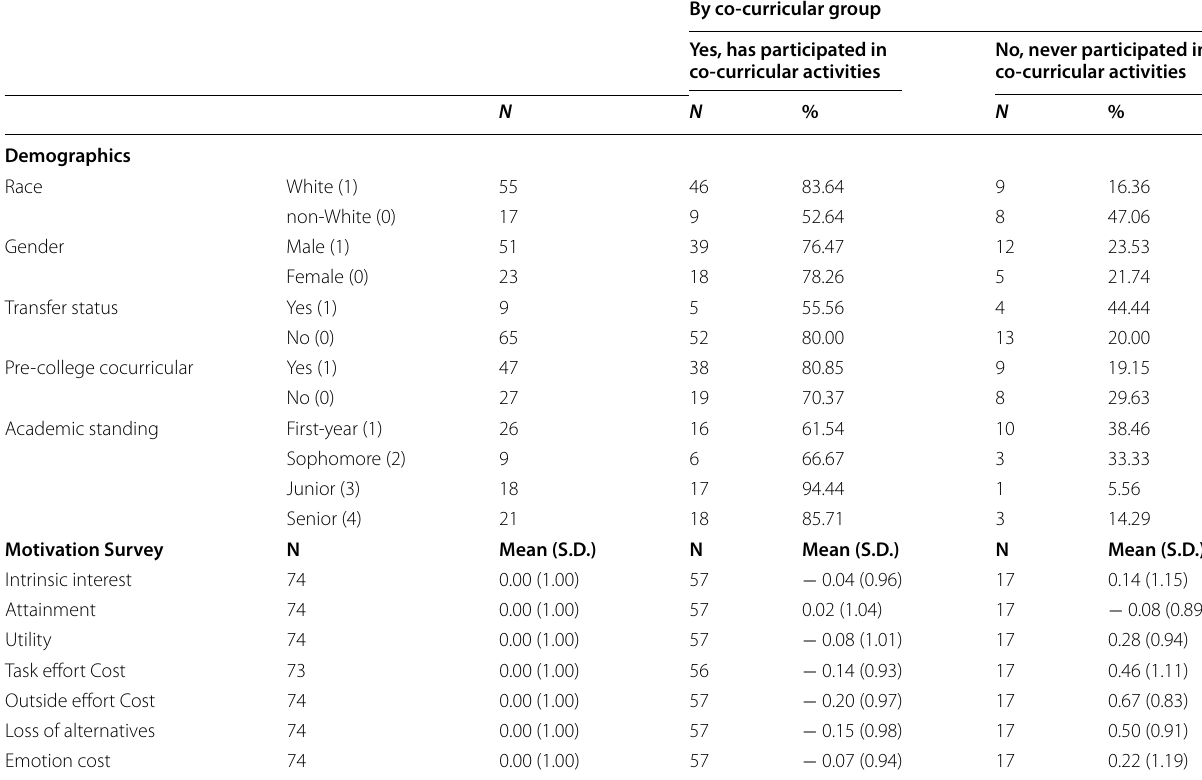
Table 1 Descriptive statistics for co-curricular motivation